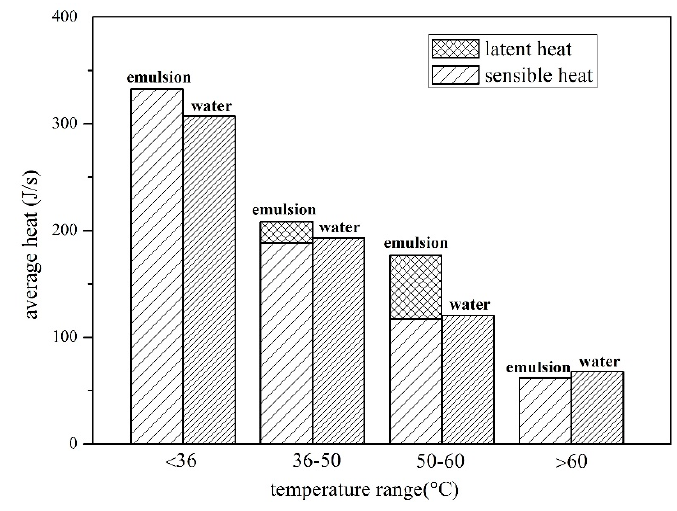
ff erent temperature ranges.